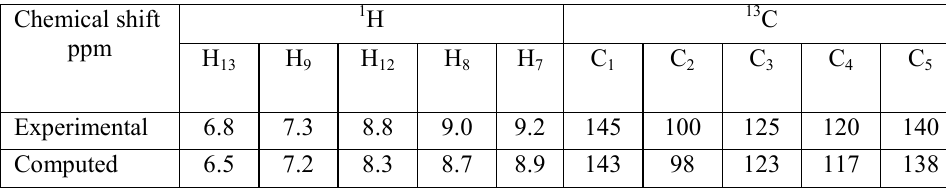
Table 5 . 1 H and 13 C-NMR chemical shifts (  , ppm) for 2-amino-3-nitropyridine (ANP). Chemical